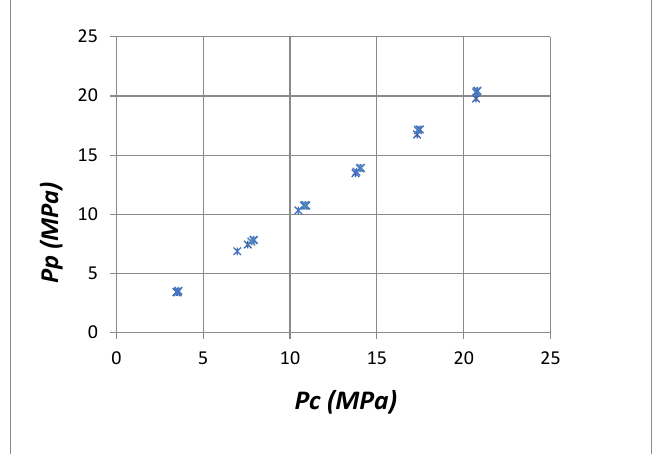
Figure 4. Variation of the pore pressure with the hydrostatic stress for the seven samples.